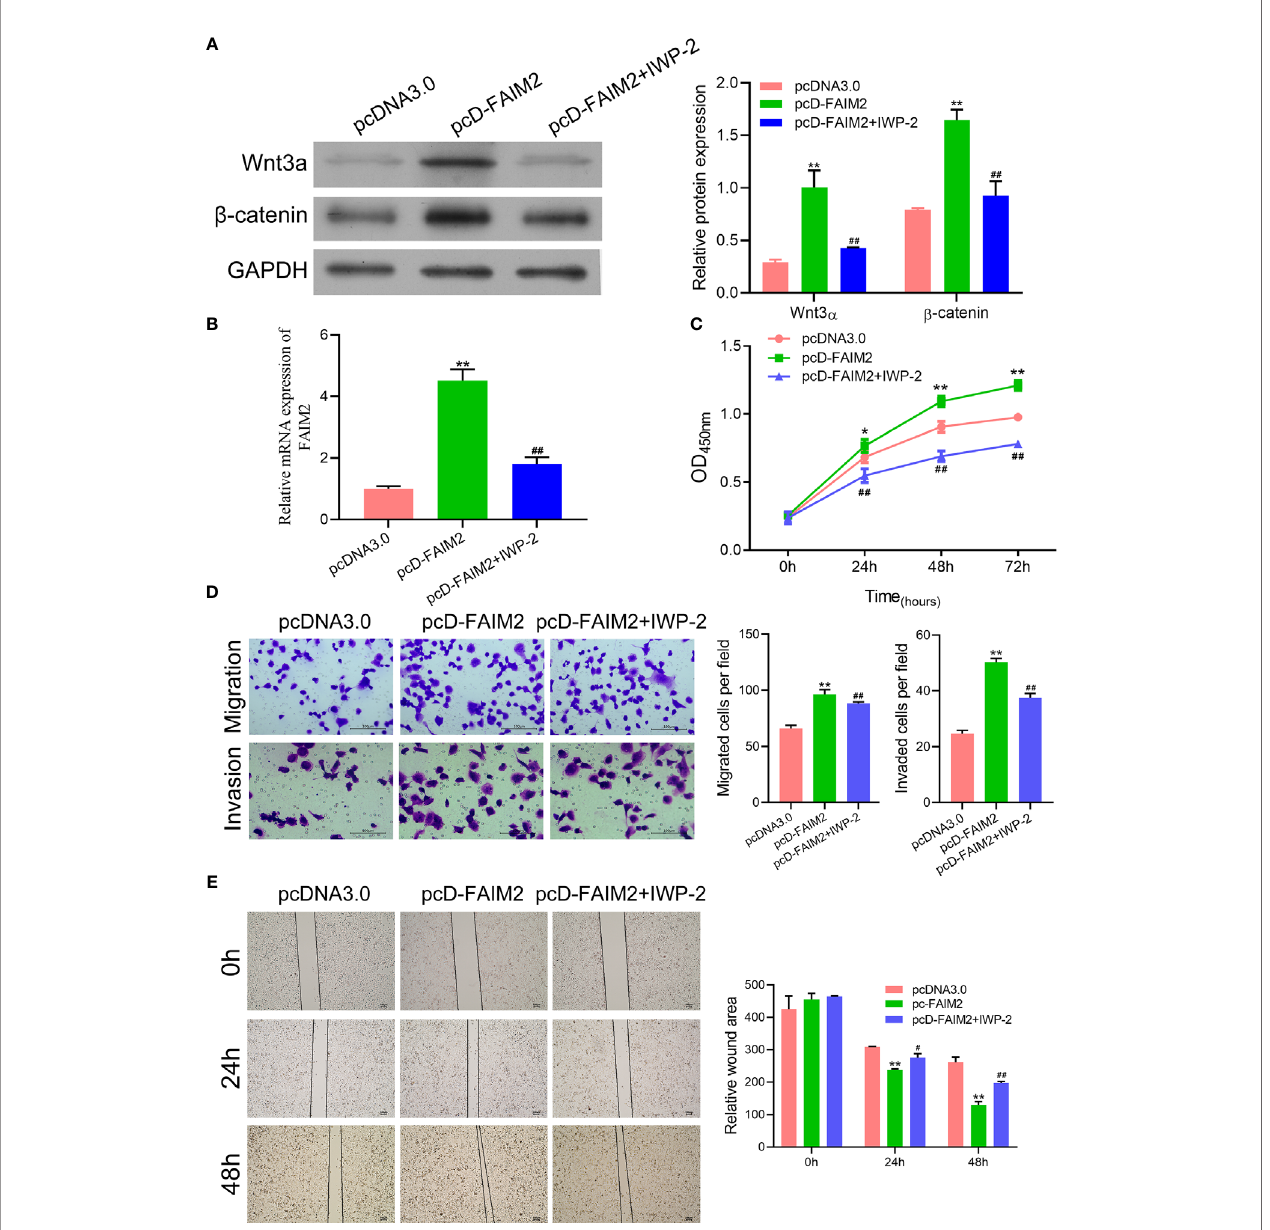
FIGURE 7 | FAIM2 promoted HARA cell migration and invasion by activating the Wnt signaling pathway. Following pcD-FAIM2 transfection and IWP-2 treatment, (A) the levels of Wnt3a and b -catenin protein expression were examined by Western blotting. (B) FAIM2 mRNA expression was measured by qRT-PCR. (C) Cell viability was detected by the CCK-8 assay. (D) Cell migration and invasion were evaluated via the two-chamber Transwell assay. (E) The cell scratch assay was conducted to further test for HARA cell migration. P < 0.05, *; P < 0.01, ** vs. the pcDNA3.0 group; P < 0.05, # ; P < 0.01, ## vs. the pcD-FAIM2